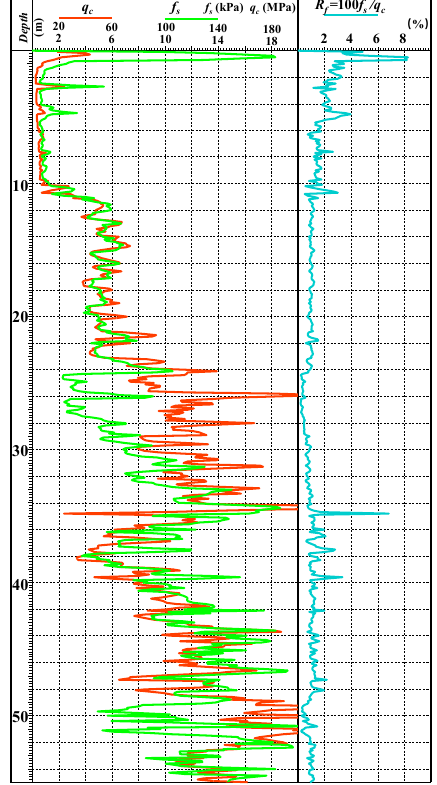
Figure 4. The cone penetration curves of the site.